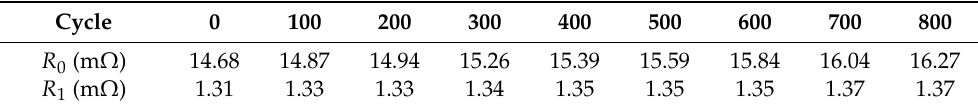
Table 3. Resistance R 0 and resistance R 1 at different cycle numbers (100% SOC).